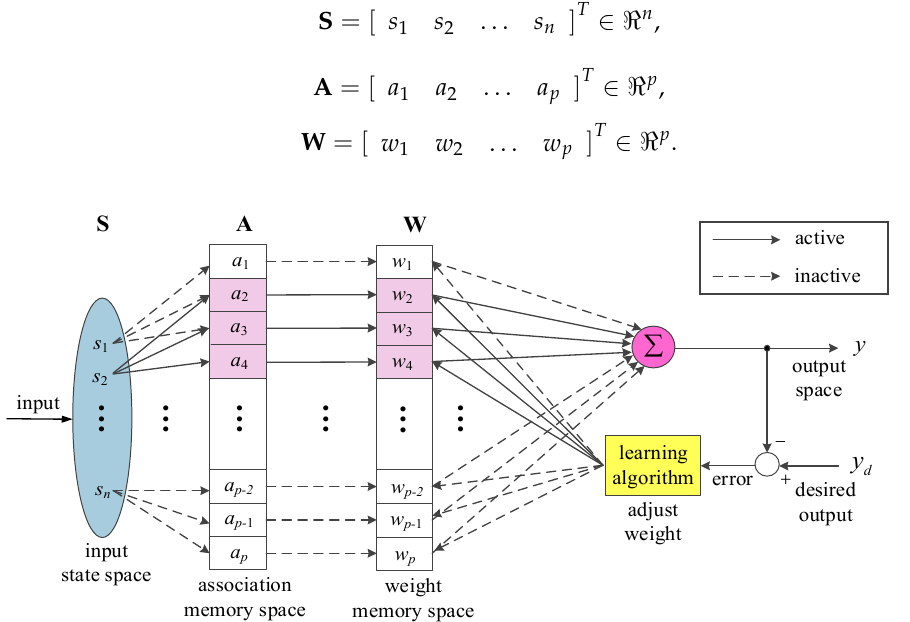
Figure 1. Schematic diagram of cerebellar model articulation controller